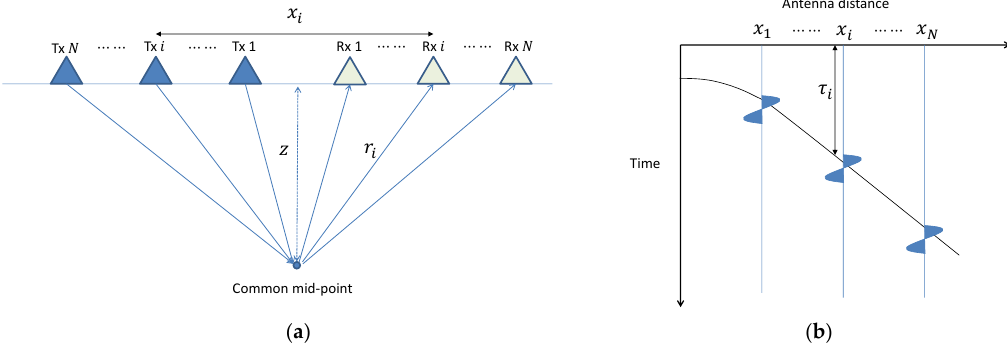
Figure 1. Configuration used to obtain a CMP dataset. ( a ) Data acquisition. ( b ) Corresponding CMP